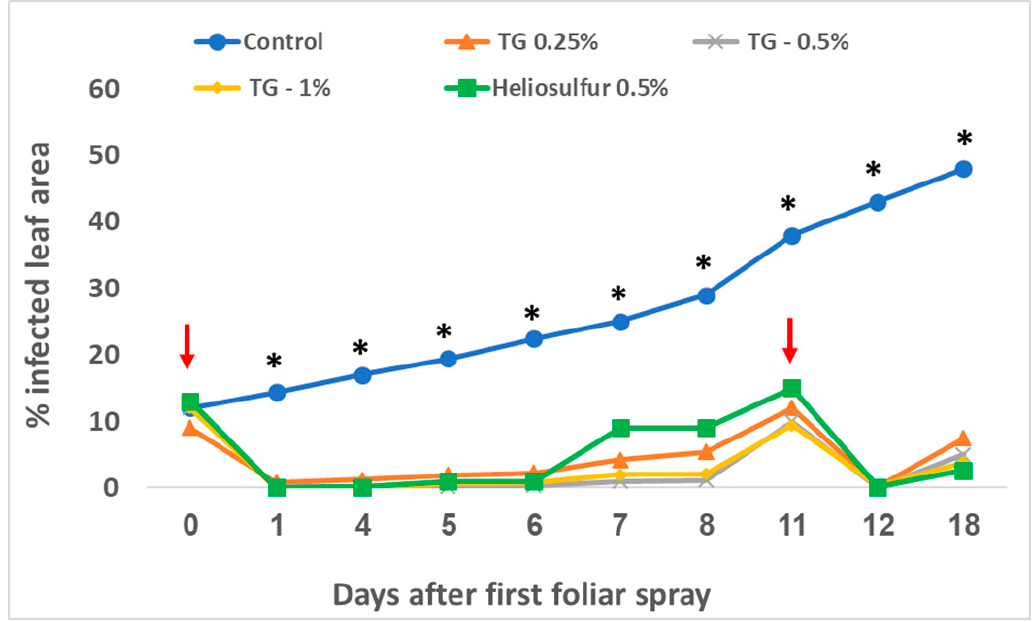
Figure 6. Suppression of powdery mildew colonies on cucumber leaves following application of Timorex Gold (TG) and Heliosulfur and the e ff ect of re-application 11 days later. Treatments were applied on day 0 and percentage of infected leaf area was evaluated at intervals after the first application. Treatments were re-applied in the same manner on days 11 and the plants were evaluated at intervals afterwards. Arrows represent the application days. Asterisks over the control indicate significant di ff erences (* p < 0.01) according to the Tukey–Kramer test.